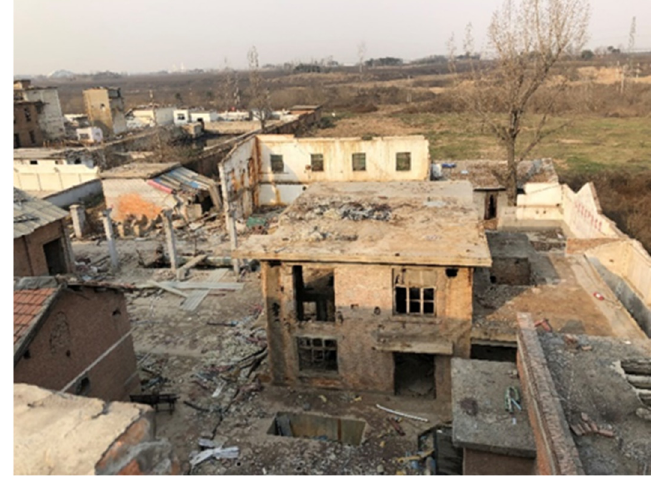
Figure 7. Abandoned factory site of the Jiaoda Ruisen chemical plant in the study area.